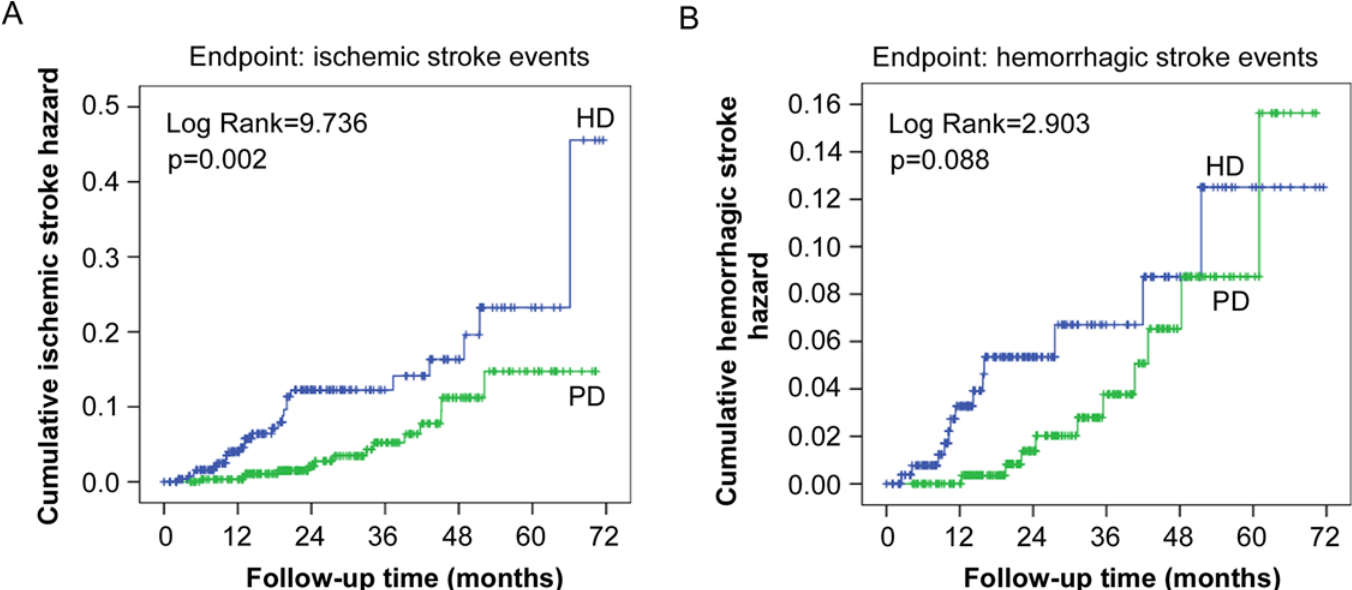
Fig 2. Cumulative hazard of ischemic and hemorrhagic stroke events in hemodialysis and peritoneal dialysis groups. (A) Cumulative hazard of ischemic stroke. The hazard ratio in the hemodialysis group compared to the peritoneal dialysis group was 2.62 (95% confidence interval, 1.56 – 4.58). (B) Cumulative hazard of hemorrhagic stroke. HD, hemodialysis; PD, peritoneal dialysis.